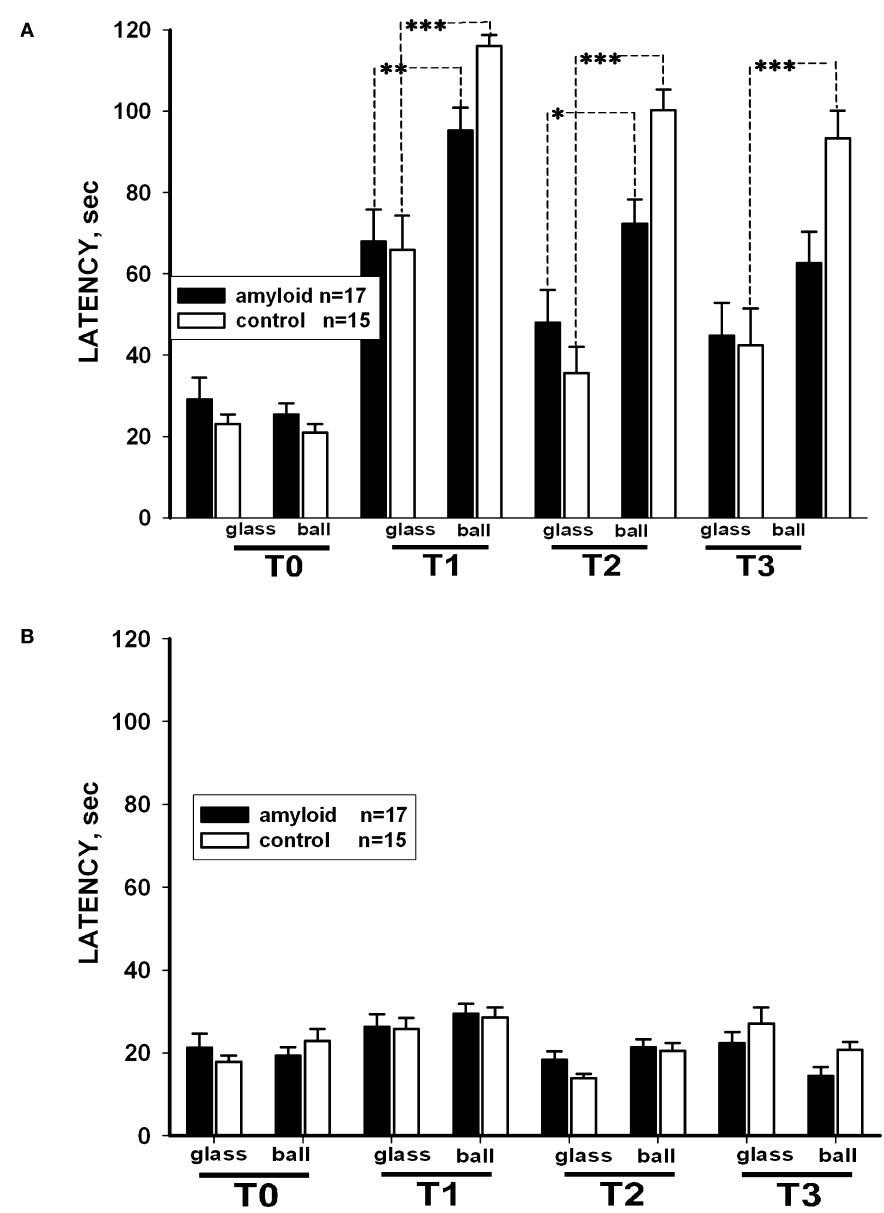
Figure 4 | Changes in latency of conditioned food grasping in tests performed before learning (T0), after 2 (T2), 5 (T2) and 14 days (T3) after learning in two contexts: on the ball (reinforced context) and on the glass. (A) The averaged latency of carrot bites in control snails ( n = 15) and β AP-injected snails ( n = 17). Y -axis – latency period (seconds) of fi rst bite of the carrot. (B) The latency of cabbage bites in control snails ( n = 15) and β AP-injected snails ( n = 17). Y -axis – latency period (seconds) of cabbage bites. * p < 0.05, ** p < 0.01, *** p <